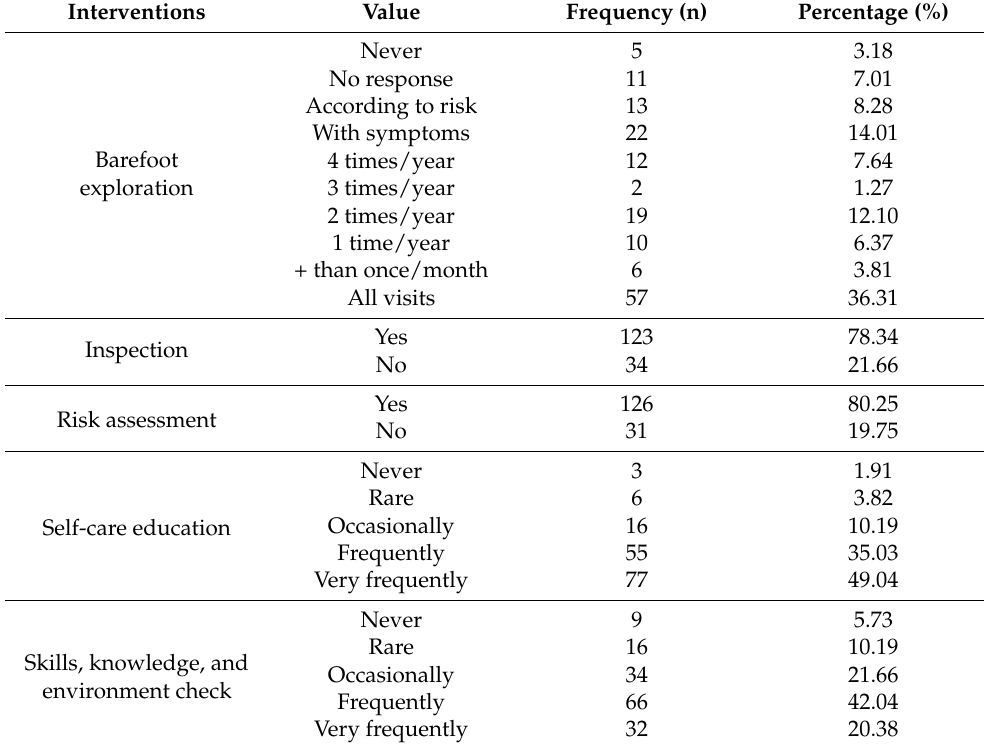
Table 4. Barefoot exploration, inspection, risk assessment, and therapeutic education. (n =